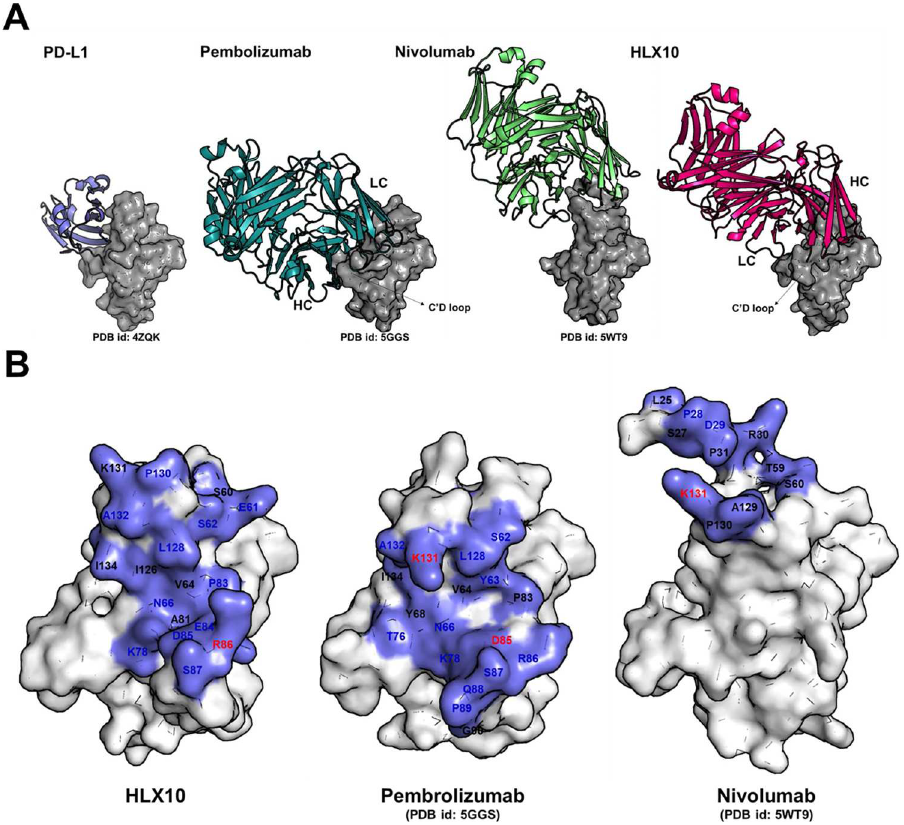
Fig 11. Comparison of binding epitope of HLX10 with Pembrolizumab and Nivolumab. (a) Binding of Nivolumab is mainly located on the top (N-terminal extension, BC loop, and FG loop) of h-PD-1, whereas Pembrolizumab and HLX10 is located on CC’FG sheets of h-PD-1. hPD-1 is represented as surface in grey. PD-L1, Pembrolizumab, Nivolumab, and HLX10 are colored in slate, deep teal, lime and magenta ribbon, respectively (b) Residues of hPD-1 contribute to the interactions with different binders. hPD-1 is represented as white surface with binding epitope colored in slate. The residues which are involved in hydrogen bond, salt bridge and hydrophobic interaction are colored in blue, red and black,